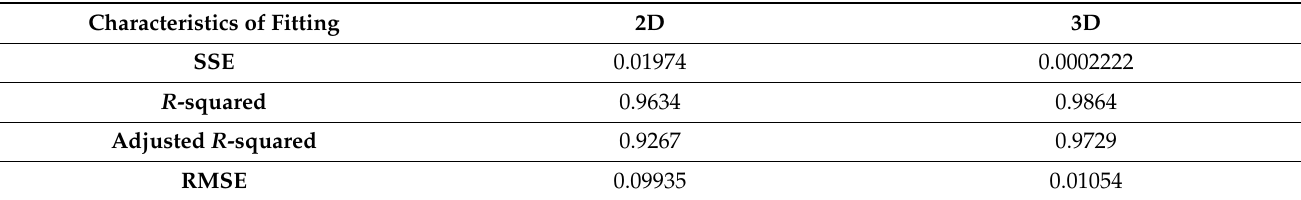
Table A4. The goodness of fit of the logistic growth